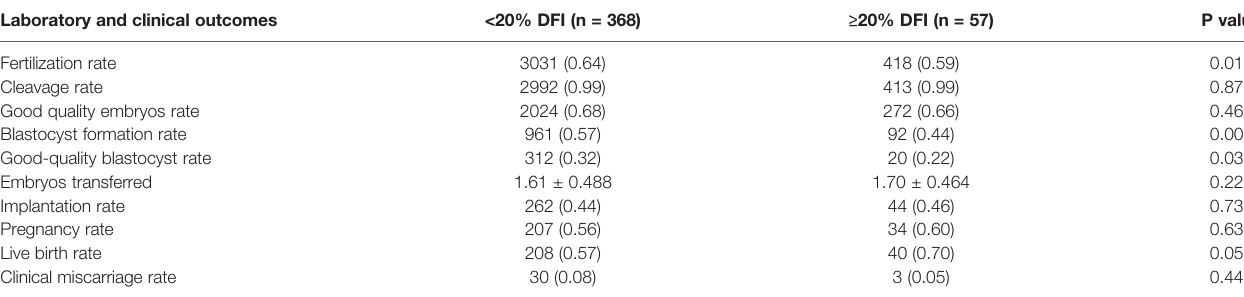
TABLE 4 | Laboratory and clinical outcomes in group 2 with high and low DFI. Laboratory and clinical